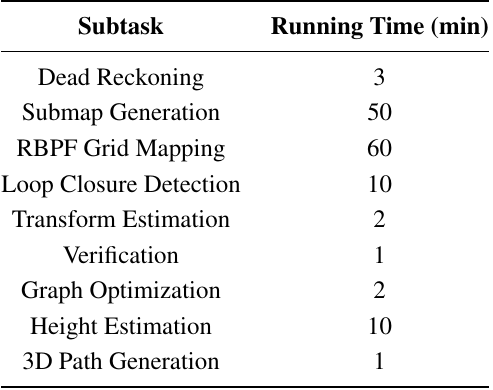
A rough estimate of the running time for the various stages of the proposed algorithm for a 40 min data collection.